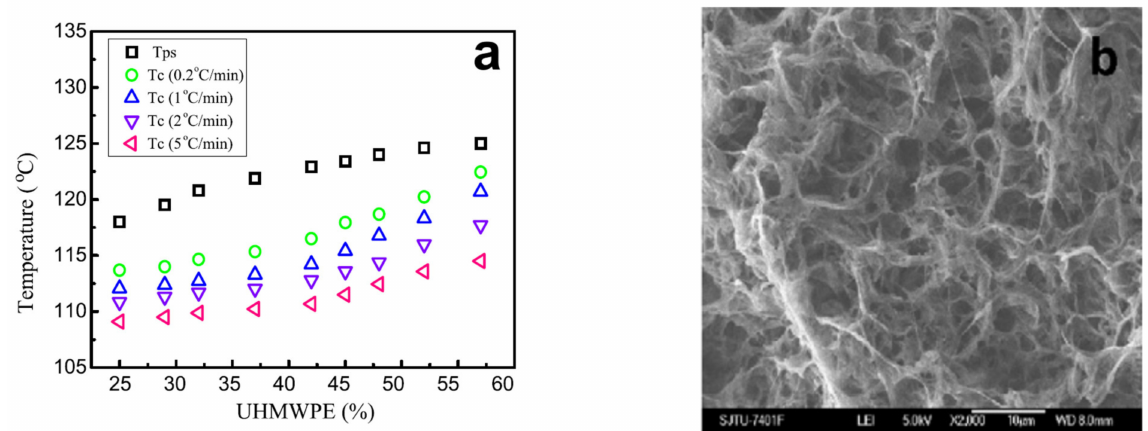
Figure 8. ( a ) Phase diagram for the UHMWPE mixture with LP (the methods used to obtain data are shown in the legend: T ps is the rheological method; T c is the DSC method at the indicated cooling rates) and ( b ) SEM image of the cross-section of the membrane prepared through annealing of the UHMWPE mixture with LP containing 25 wt% of the polymer at 115 ◦ C and subsequent cooling. Reproduced with permission from S. Liu, C. Zhou, W. Yu, Journal of Membrane Science; Published by Elsevier,